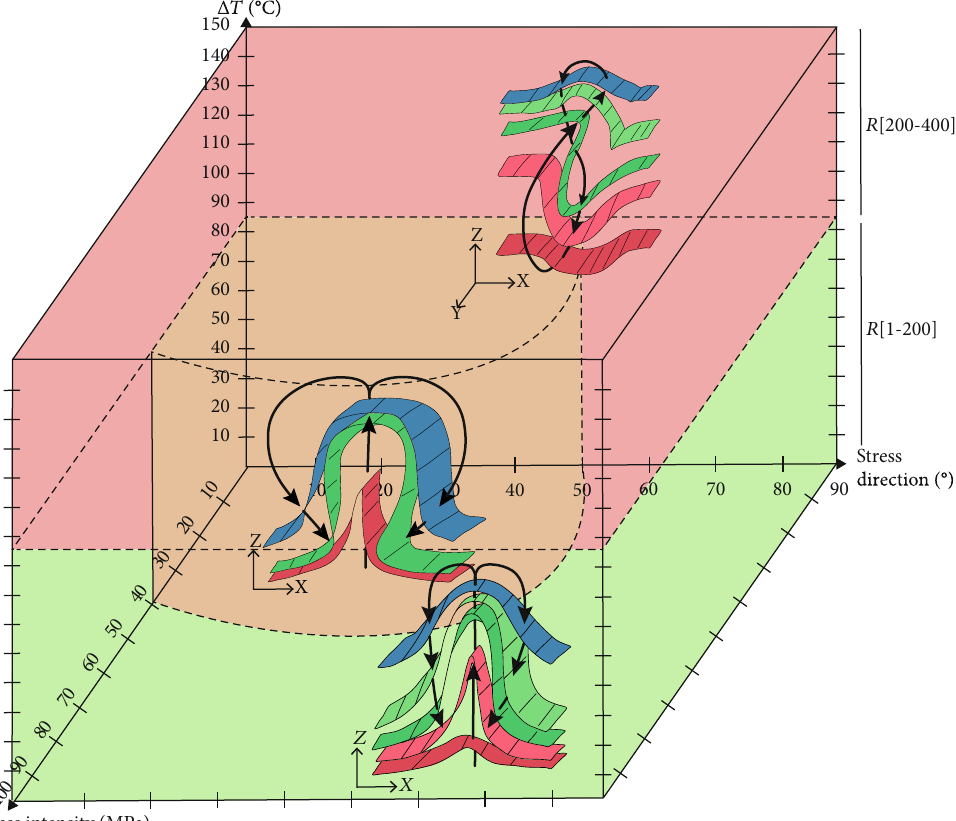
Figure 12: Diagram of convective regimes. The distorted planes represent the isotherms. The arrows represent the circulation of fl uids. In the brown area are the blob-like convection patterns. In the green zone are the fi nger-like convection patterns. In the red zone are the double- convective